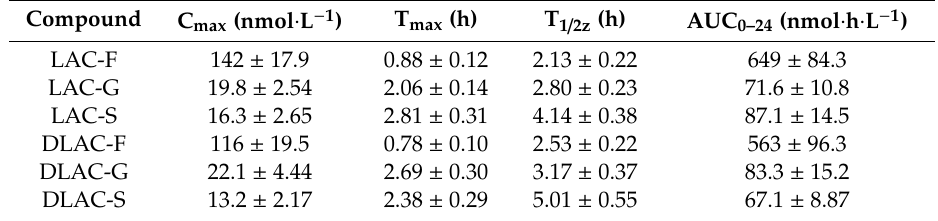
Figure 2. Characterization and quantification of serum concentrations of sesquiterpene lactones and metabolites over 24 h in 16 healthy adults after Brussels/witloof chicory consumption. ( A ) Representative chromatographic profiles of free sesquiterpene lactones in human serum sample collected at baseline ( A , top) or at 1 h after the consumption of Brussels/witloof chicory ( A , bottom). ( B – D ) Serum concentration-time curves (0–24 h) of free and glucuronide/sulfate conjugated LAC ( B ), DLAC ( C ), and the sum total of sesquiterpene lactones ( D ). Values are the means ± SEM, n = 16. * Different from baseline, p < 0.05. SLs, sesquiterpene lactones; LAC, lactucin; DLAC, 11 β ,13-dihydrolactucin; IS, internal standard; F, free; G, glucuronide; S, sulfate. Table 1. Pharmacokinetic characteristics of sesquiterpene lactones and metabolites in serum over 24 h in 16 healthy adults after Brussels/witloof chicory consumption a.